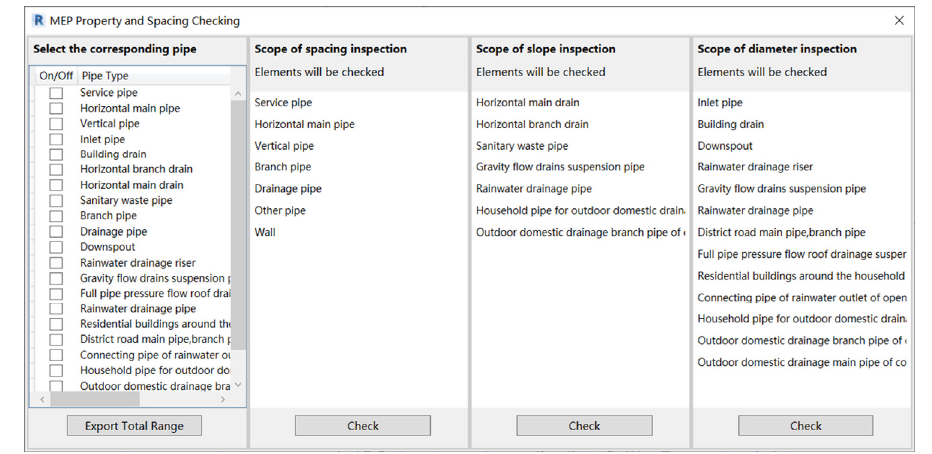
Figure 15. The user interface of property checking and spacing checking.